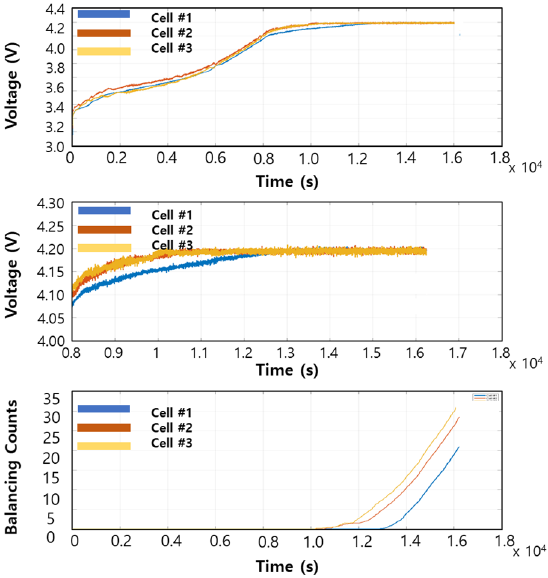
Figure 6. Experimental results from module #2. Table 7. Balancing parameters from module #2.